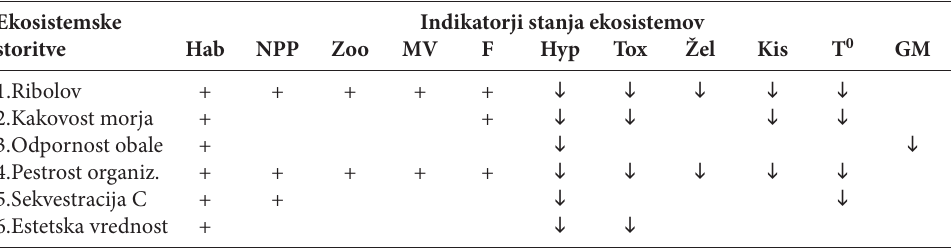
Tabela 2 : Vpliv vrednosti indikatorjev stanja ekosistemov na izboljšanje ( + ) oz. poslabšanje (  ) ekosistemskih storitev. Indikatorji stanja : Hab = stanje habitatov; NPP = neto primarna produkcija; Zoo = številčnost zooplankto- na; MV = živi morski viri; F = številčnost filtratorjev; Hyp = časovna in prostorska razsežnost hipoksij/anoksij; Tox = pogostost pojavov škodljivih cvetenj fitoplanktona; Žel = številčnost želatinoznih organizmov (meduze, rebrače); Kis = kisanje morja; T 0 = površinska temperatura; GM = gladina morja Ekosistemske storitve : (1) ribolov (ribe, meh- kužci, raki); (2) vzdrževanje kakovosti morja (kroženje hranil, prehranjevanje filtratorjev, stabilizacija morskega dna); (3) odpornost obale (stabilizacija obale, manjšanje erozije, zadrževanje poplav); (4) podpora biotski pestrosti (biološko strukturirani habitati, različne vrste, reprodukcija, zaščita pred predatorji); (5) sekvestracija ogljika